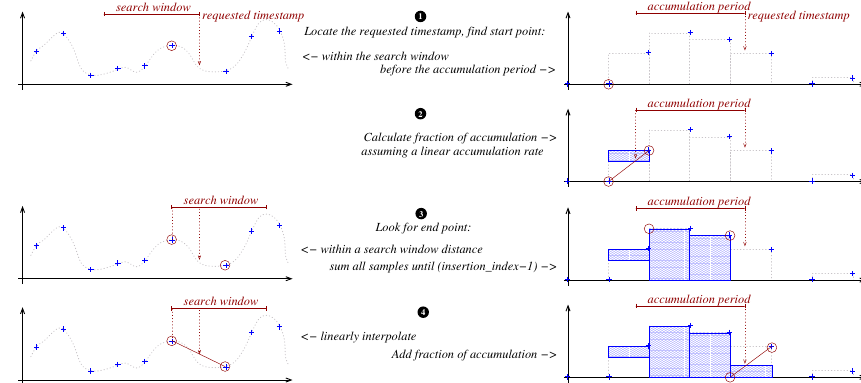
Figure 7. Resampling and reaccumulation